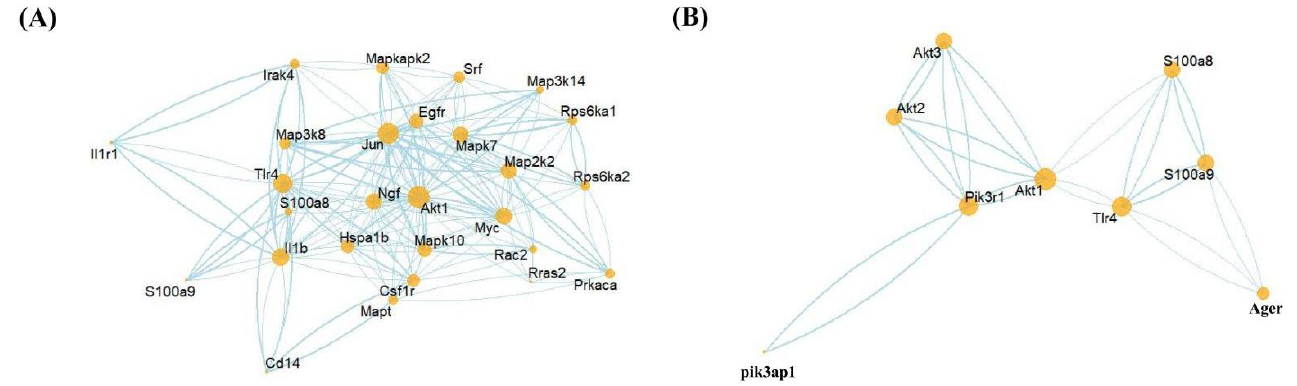
Figure 8. Protein–Protein Interaction Networks (PPI) prediction. The PPI network between the MAPK-signaling-pathway-related genes ( A ); PI3K-AKT-signaling-pathway-related genes ( B ); and S100a8, S100a9, and their receptor TLR4. The node size represents the connectivity degree, and the closer to center, the more critical it is.